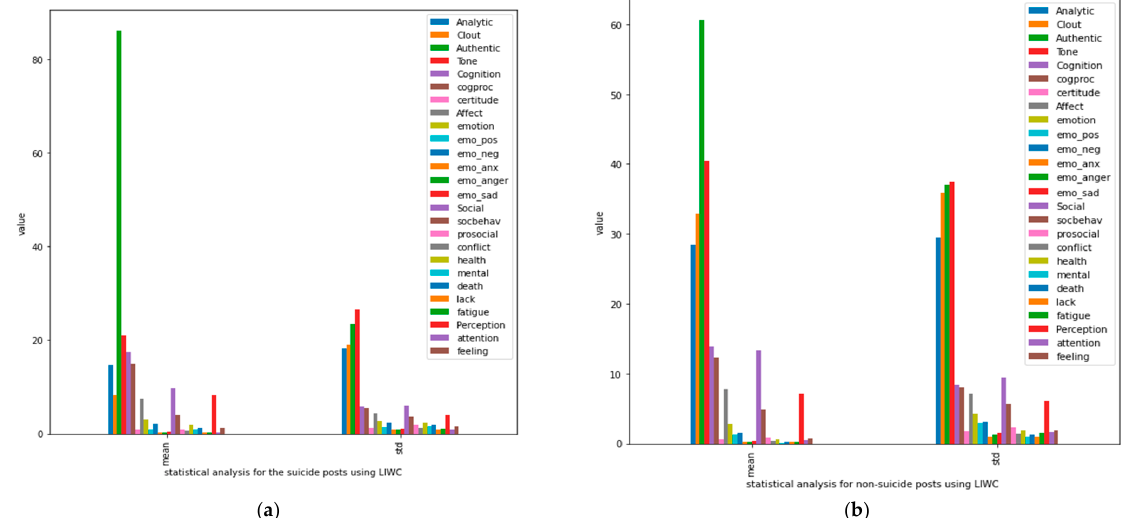
Figure 5. Graphical representation of the statistical analysis of ( a ) non-suicidal and ( b ) suicidal posts determined based on LIWC features.